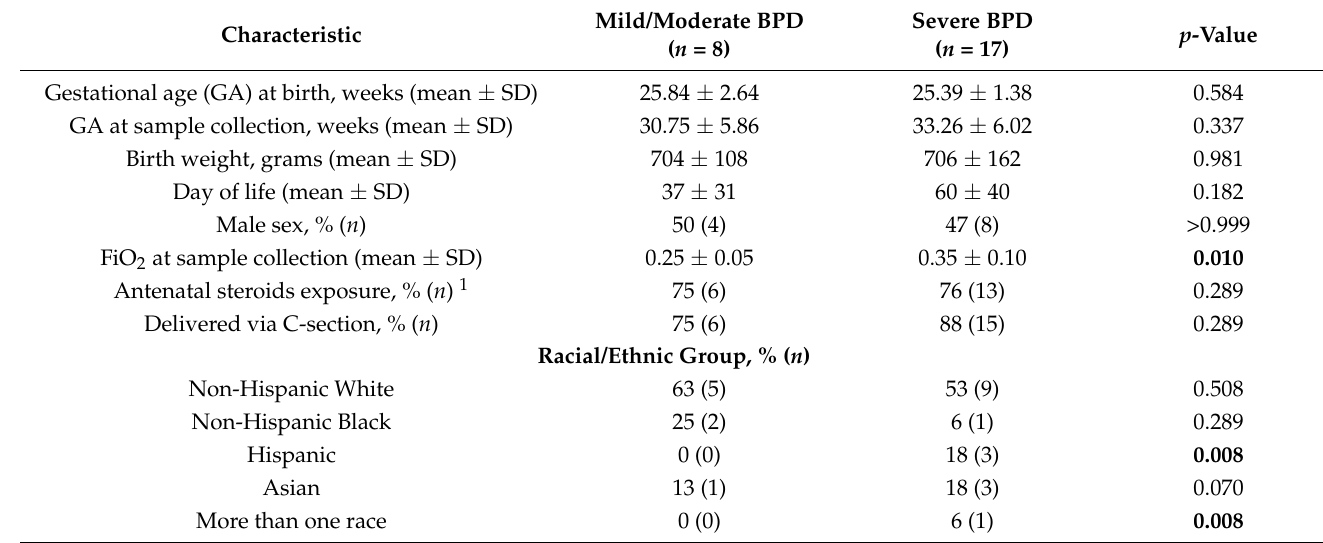
Table 1. Patient demographics at study